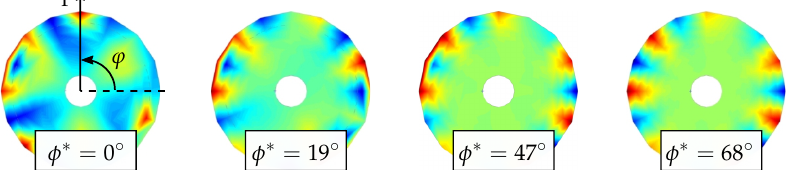
Figure 5. Affect of the phase angle on the representation of mode shapes on the example of the mode shape (7,1) at 4 different phase